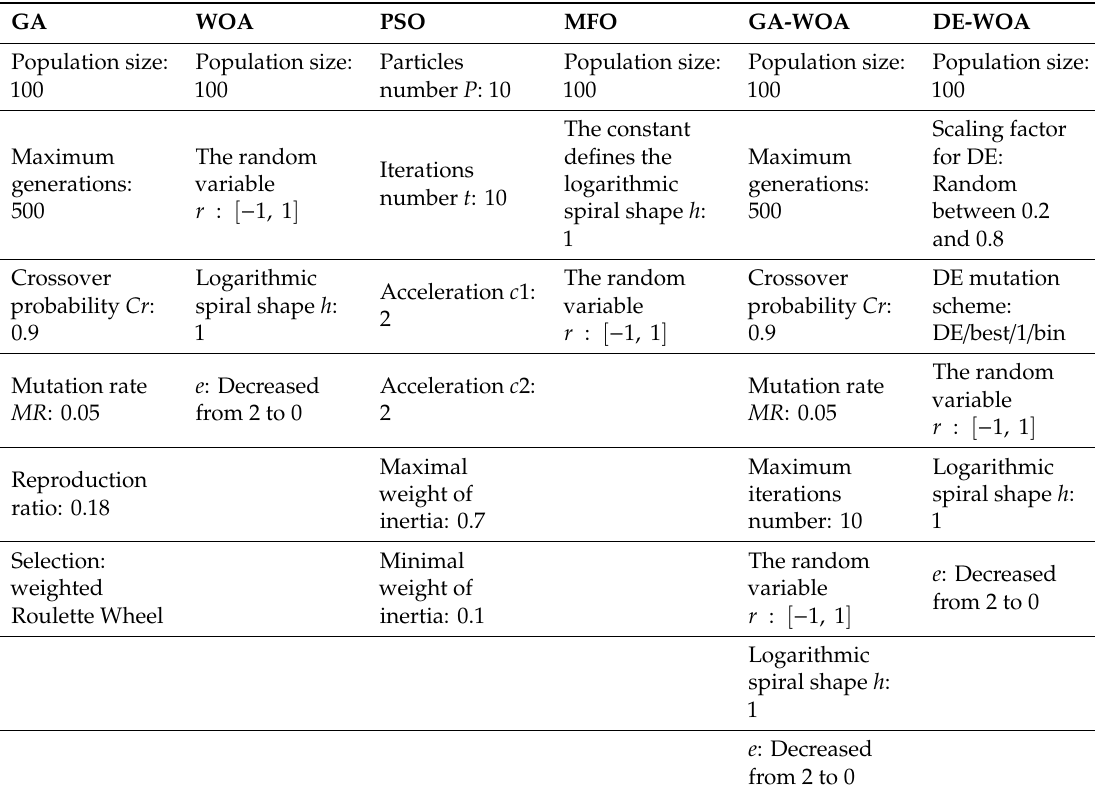
Table 4. The parameter list used in this work.